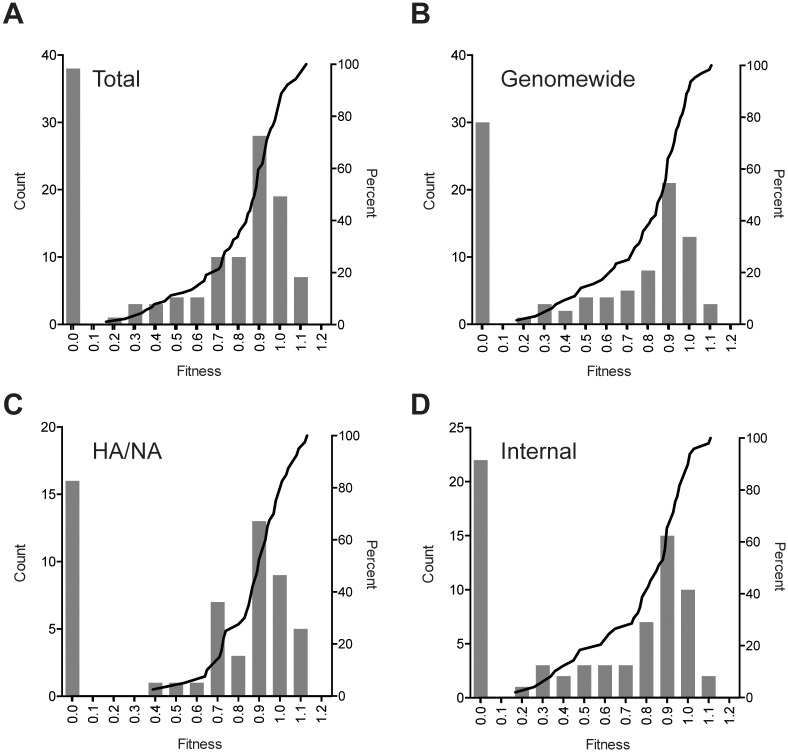
Histograms and cumulative distribution functions of influenza A virus mutational fitness effects.Data are shown for all single nucleotide mutants (A, n = 128), the randomly selected genome-wide dataset (B, n = 95), the HA and NA dataset (C, n = 57), and the “internal” dataset (D, n = 71). Relative fitness values, bin width 0.1, are shown on the x-axis, and number of mutations in each histogram bar (left) and percent in cumulative distribution (right) are shown on the y-axes. The cumulative distribution functions show only the viable mutations (fitness > 0).